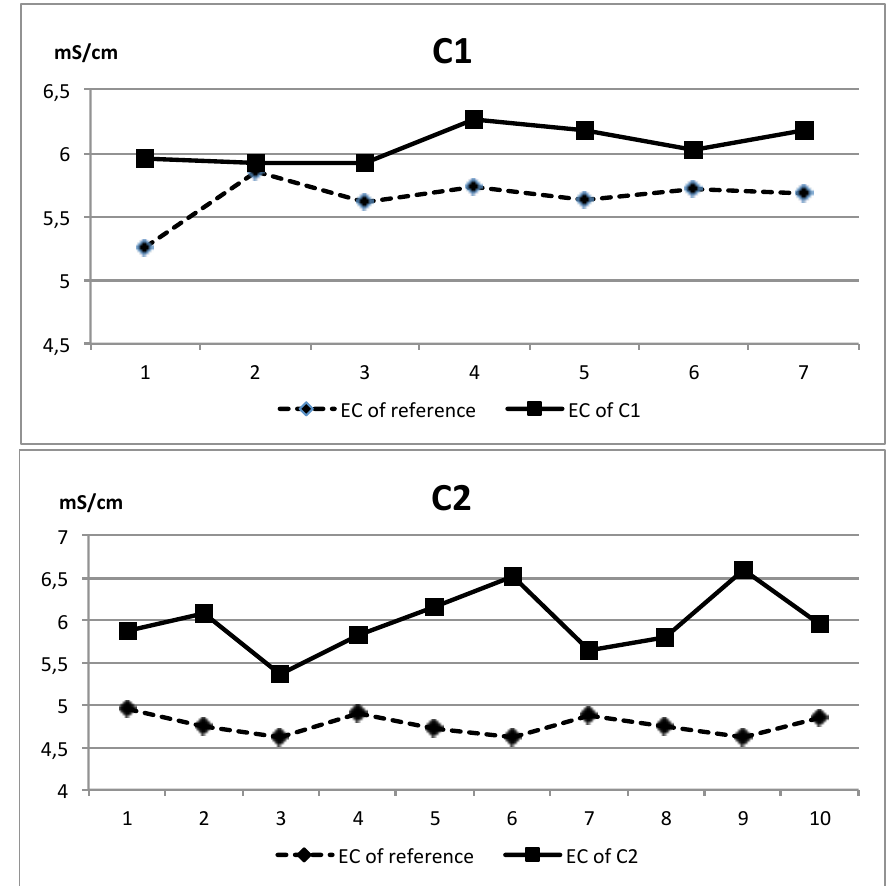
Figure 13. Examples of the performance of commercial probes versus laboratory probe on samples measured